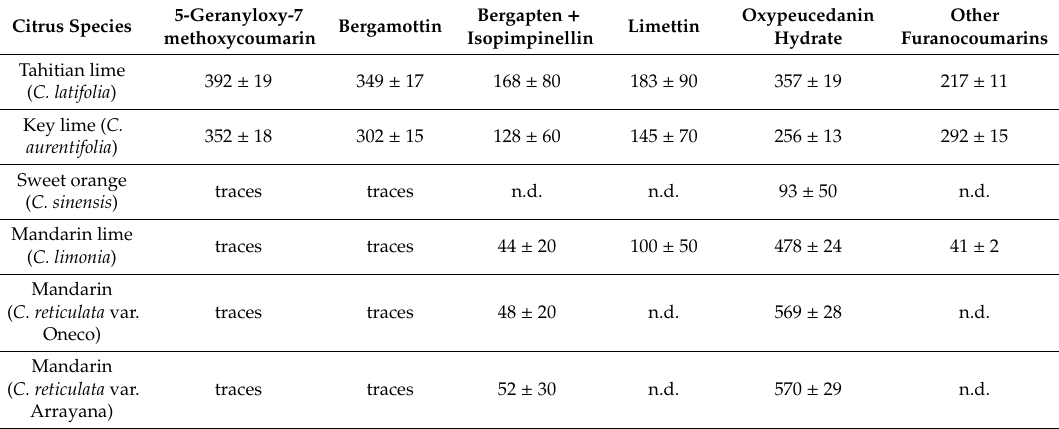
Table 7. Composition of coumarins in some Columbian citrus fruits determined by HPLC-DAD (diode array detection) from methanolic extract of peels [108]; (values are expressed in µ g / g of fresh